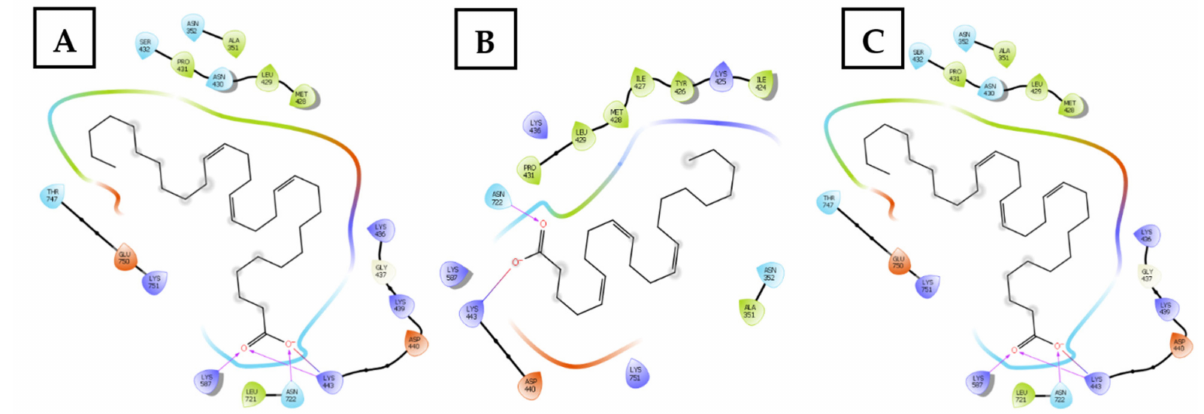
Figure 6. Ligand interaction diagram for acids 13b ( A ), 13c ( B ) and 13f ( C